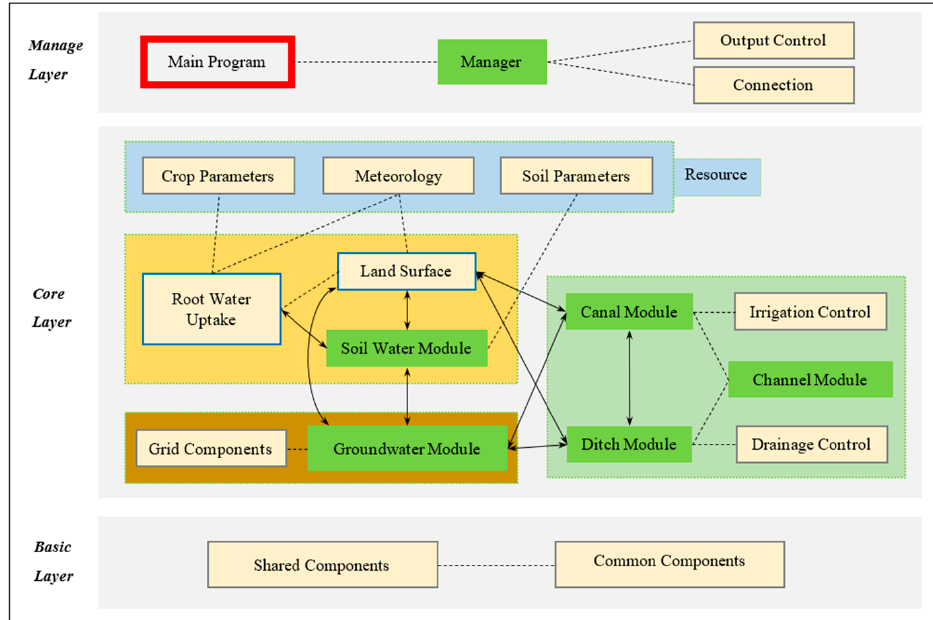
Figure 5. A schematic structure of Irrigation Districts Model (IDM).